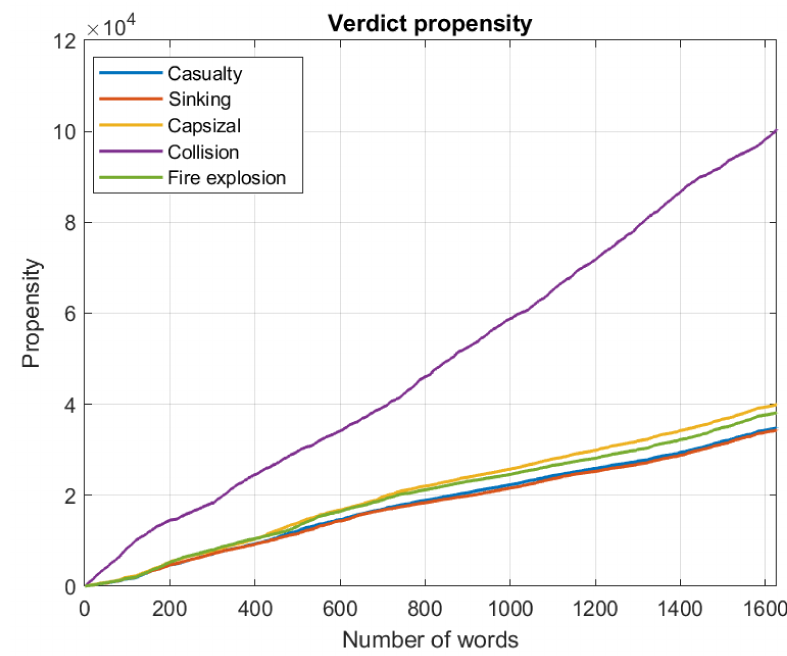
Figure 6. Verdict propensity of “ordinary collision” accident cases.